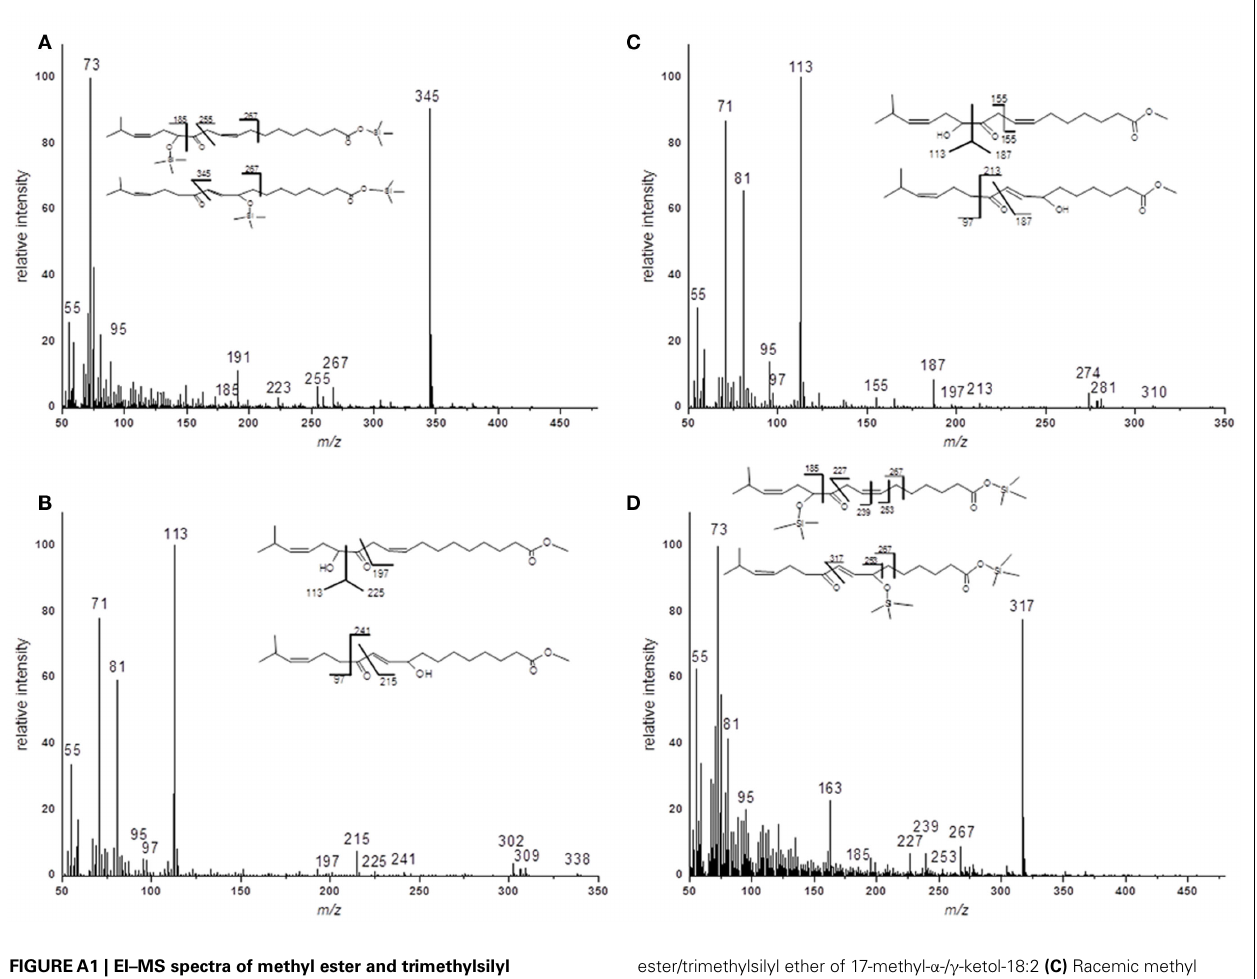
FIGUREA1 | EI–MS spectra of methyl ester and trimethylsilyl ester/trimethylsilyl ether derivatives of methyl-branched ketols. (A) Racemic methyl ester of 17-methyl- α -/ γ -ketol-18:2 (B) Trimethylsilyl